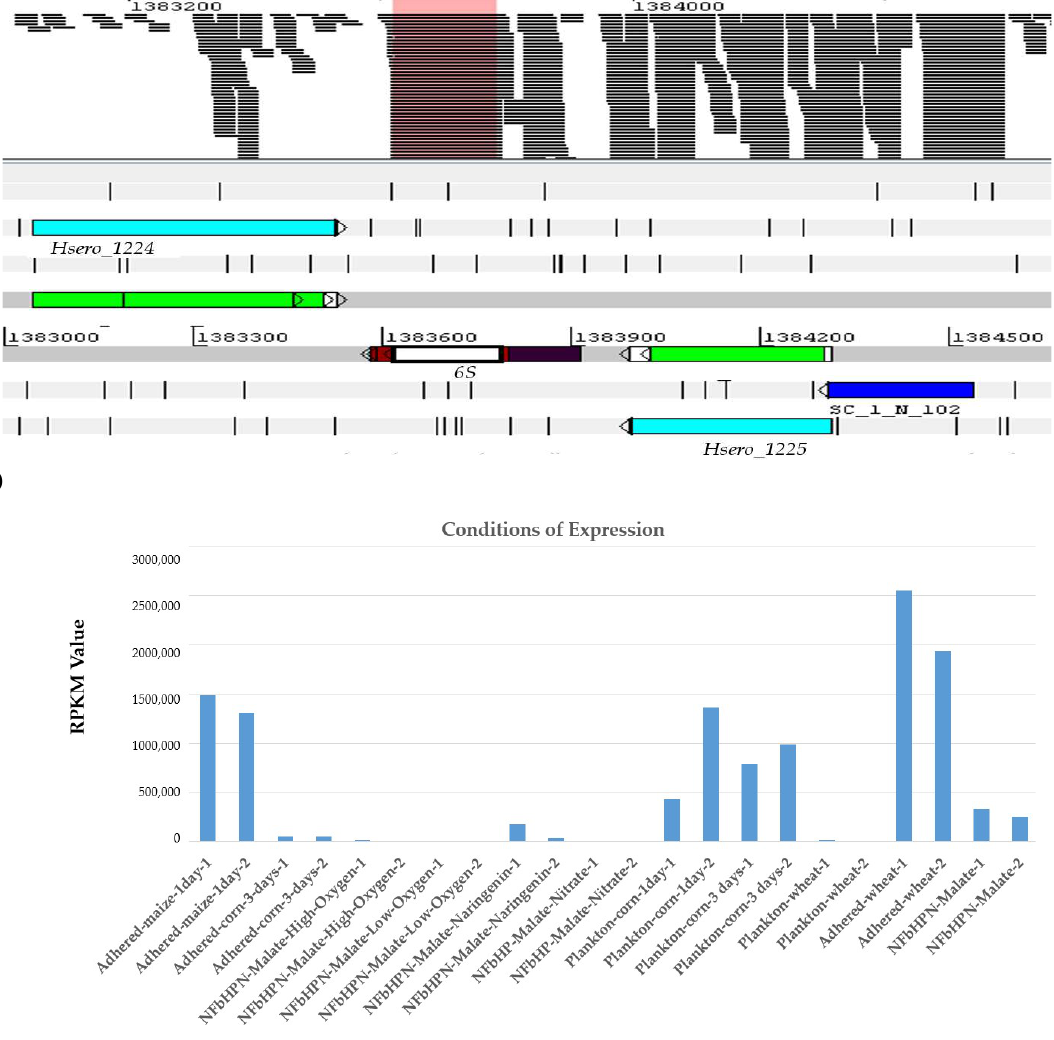
Figure 6. The sequence was located by means of the Artemis program. The readings delineated by the pink rectangle were as follows: ( a ) Visualization of expression levels of ncRNA 6S in RNA-seq assays in H. seropedicae SmR1. In the colored section, the 11 analyzed experimental conditions represented, where 1 and 2 show d.a.i (days after inoculation); ( b ) the numbers represent the value of the gene expression in RPKM.